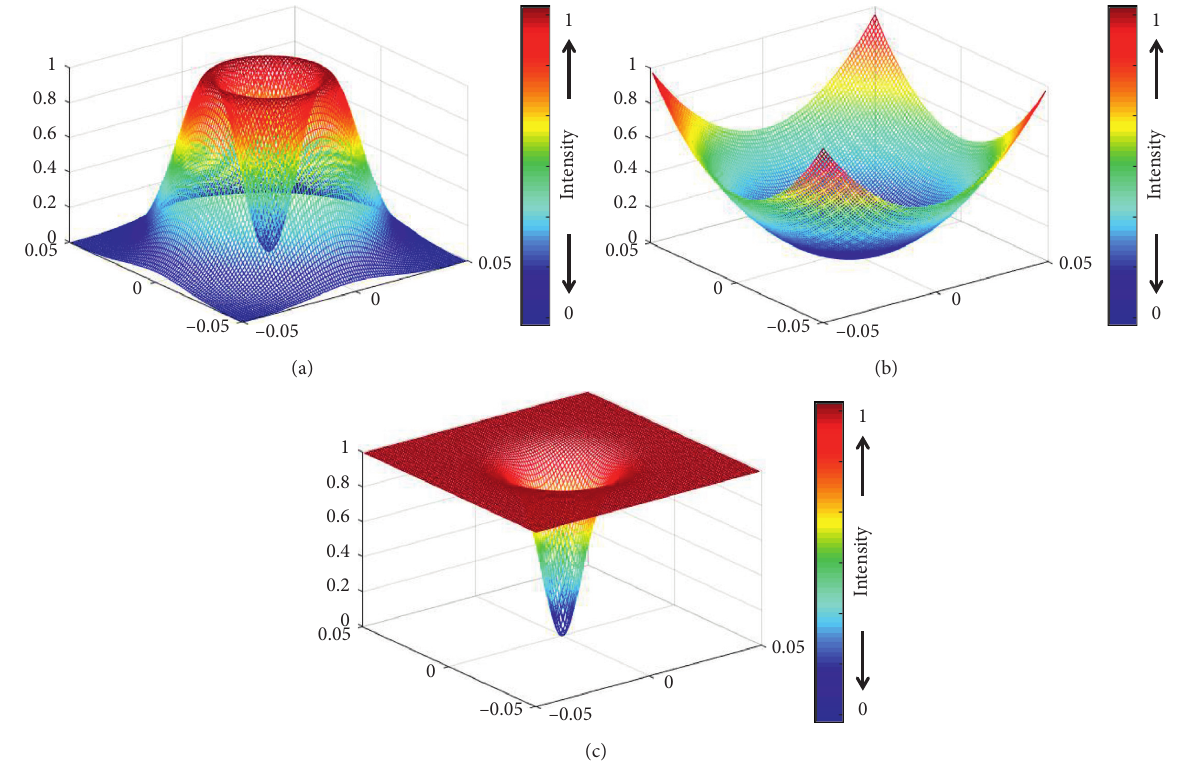
Figure 2: Possible intensity distributions for an optical vortex beam of topological charge m � 1. Note that amplitude is zero at the vortex core ( r � 0) and is surrounded by a doughnut-type intensity distribution. (a) LG variation; (b) r variation; (c) tanh variation.